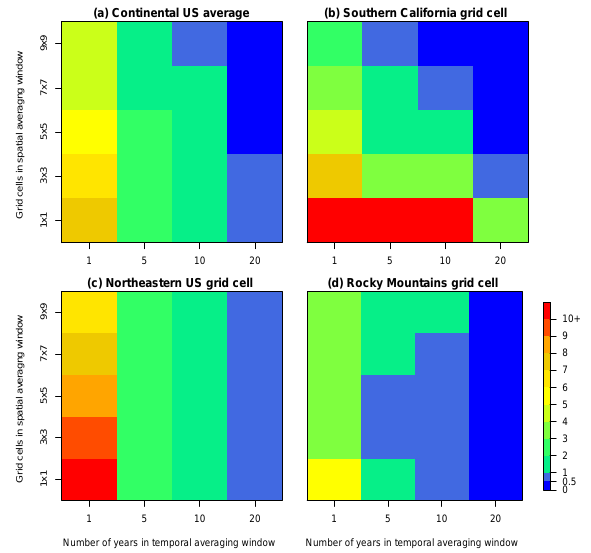
Figure 8. The maximum potential calculated MDA8 O 3 anomaly (ppbv) from the long-term mean for (a) the continental US aver- age and three individual grid cells taken from (b) southern Califor- nia, demonstrating effective temporal and spatial averaging; (c) the northeast, where spatial averaging is ineffective; and (d) the Rocky Mountains, where spatial averaging initially reduces the anomaly but then increases the anomaly as surrounding regions get included in the spatial average. The number of years included in the tempo- ral averaging window increase along the x axis and the number of grid cells included in the spatial averaging window increase along the y axis. A full map of the continental US can be found in the Supplement (Fig. S4). Note that the color scale is nonlinear, and the color transitions are selected to match the thresholds established throughout this